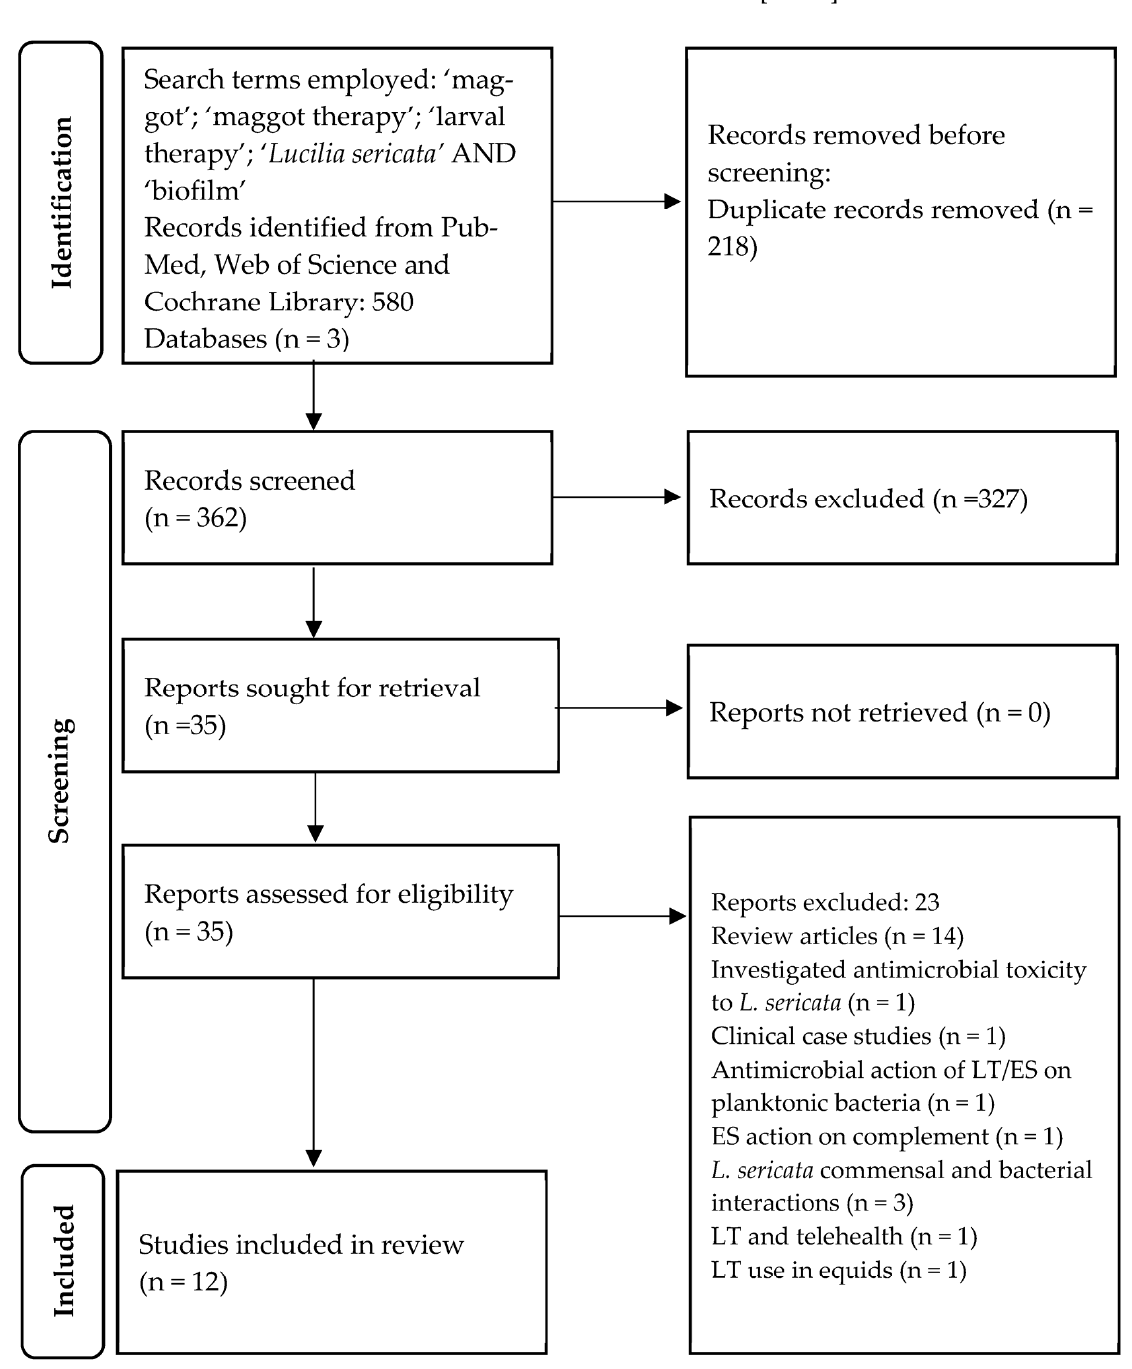
Figure 1. A PRISMA flowchart detailing the sources of literature and studies retrieved, reviewed, assessed for eligibility, and analyzed as part of this review.